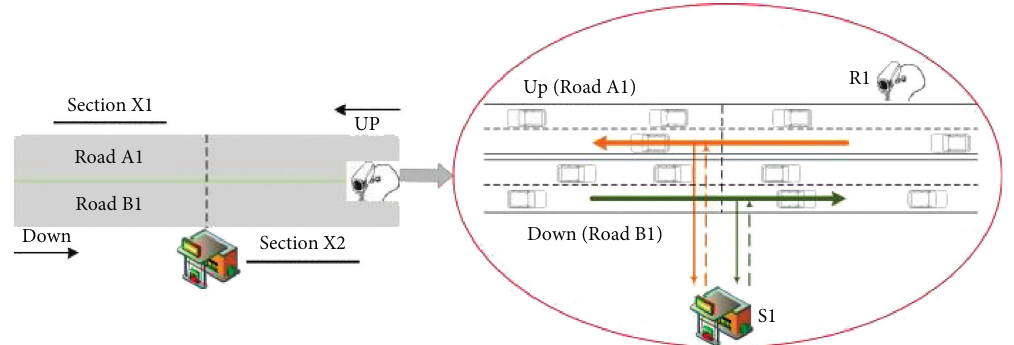
Figure 3: Schematic diagram of traffic flow calculation for Section